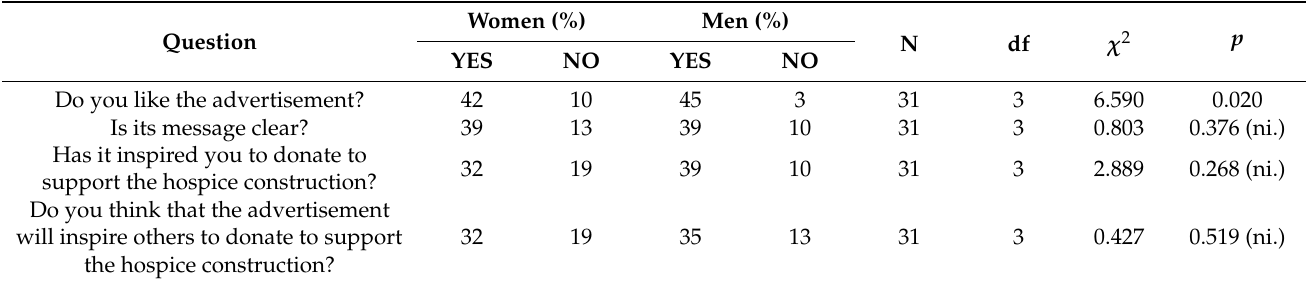
Table 1. Results of statistical analysis of responses to survey questions given by men and women. Markings: YES (answers: rather YES, definitely YES), NO (answers: rather NO, definitely